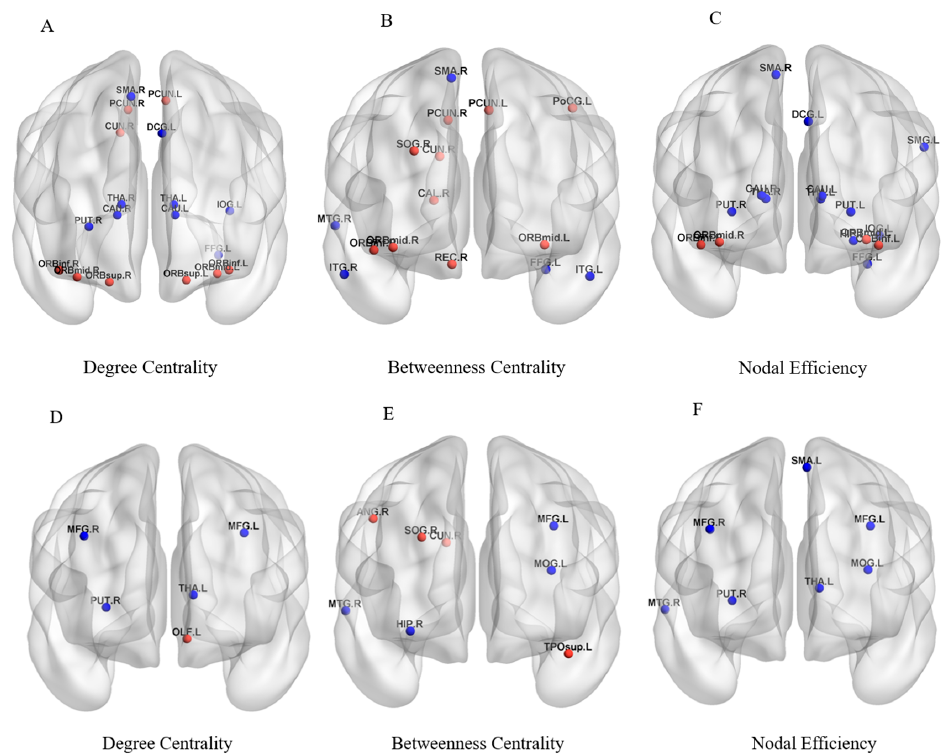
Figure 4. Brain regions with significant differences in the degree centrality ( A ), betweenness centrality ( B ), and nodal efficiency ( C ) among participants in the CKD5 ND and HC groups. Brain regions with significant differences in the degree centrality ( D ), betweenness centrality ( E ), and nodal efficiency ( F ) among participants in the CKD5 ND and HD groups. The red sphere demonstrated that nodal network properties in the CKD5 ND group were increased compared with the HC and HD groups. The blue sphere showed that the nodal network measures in the CKD5 ND group were decreased relative to the HC and HD